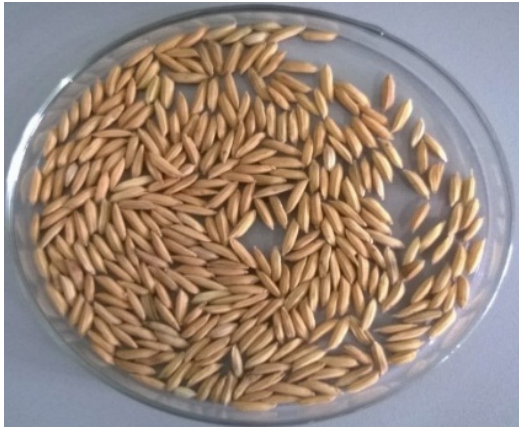
Figure 7. Paddy rice grains before the microwave drying process.